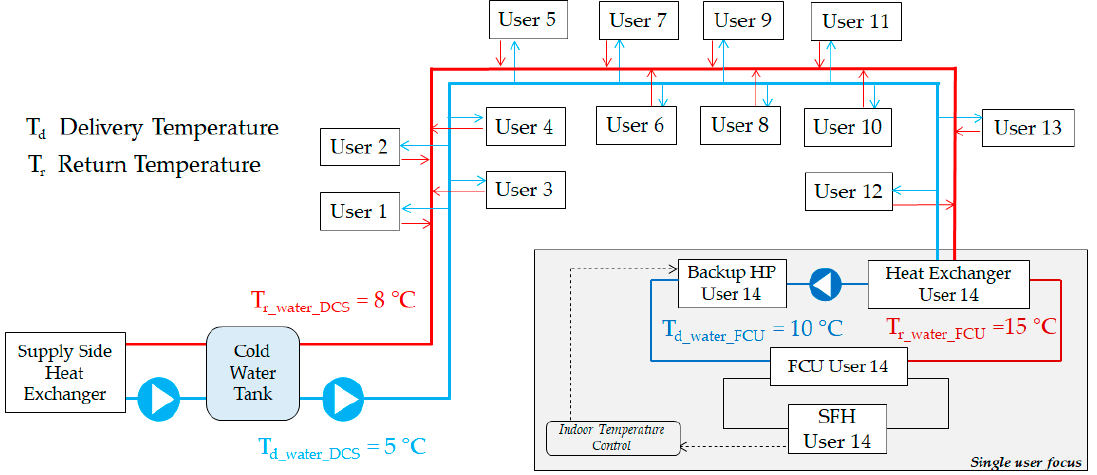
Figure 4. Residential district cooling network scheme (see Figure 1 for the details of the supply side). Focus on a single user configuration.